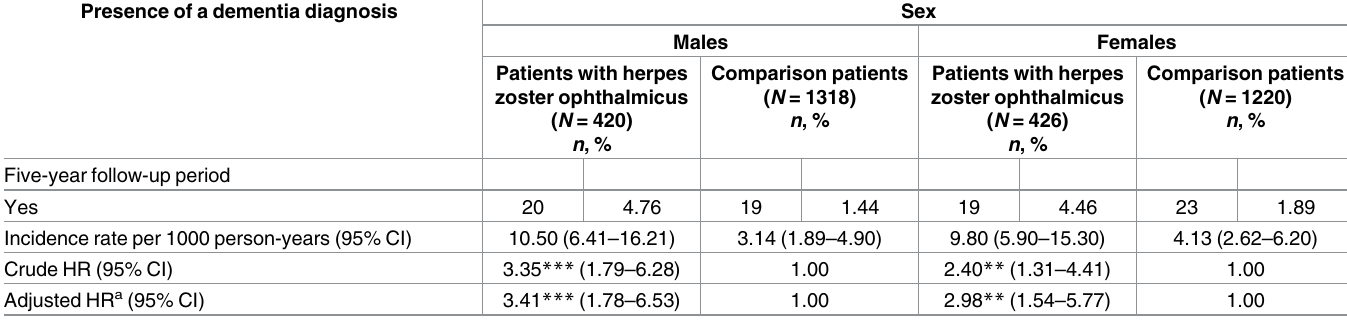
Table 4. Crude and covariate-adjusted hazard ratios (HRs) and 95% confidence intervals (CIs) for dementia during the 5-year follow-up period by